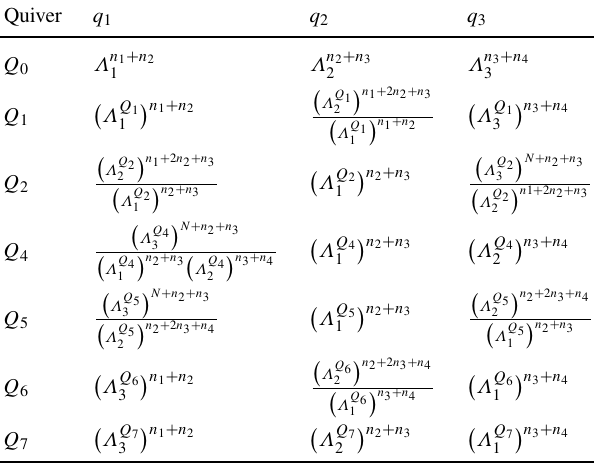
Table 2 For each quiver of Fig. 8, we list the q vs Λ map (up to sign factors, which can be found in Appendix B). The exponent of each strong coupling scale is determined by the number of effective flavours at that node in the quiver and is related to the β -function coefficient of the corresponding FI parameter